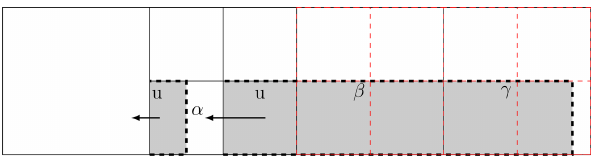
Figure 2. Illustration of the semi-Lagrangian extension for finite- volume schemes on adaptive meshes. The marks, α , β , and γ , rep- resent their underlying cells. Cell α is the arrival cell with high res- olution, while cells β and γ are coarse cells. The dashed red cells are ghost cells. The shaded domain represents the departure area determining the mass flux into the arrival